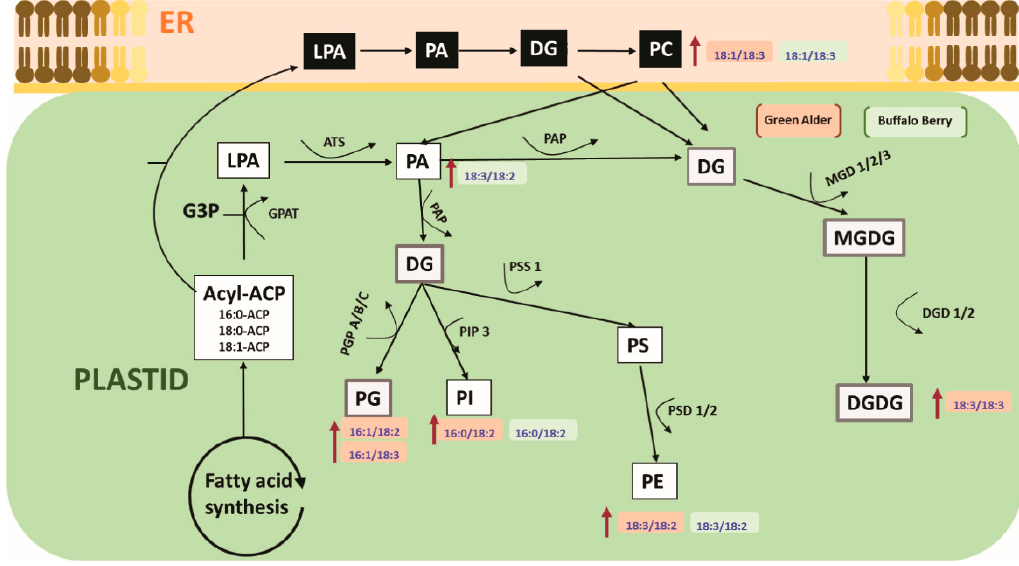
Figure 10. Proposed pathway showing the e ff ects of nanopriming with MWCNT–COOH on the membrane lipid metabolism of upland boreal forest species in response to resolving seed dormancy ER = endoplasmic reticulum, LPA = lysophosphatidic, PA = phosphatidic acid, DG = diacylglycerol, PC = phosphatidylcholine, PG = phosphatidyl glycerol, PI = phosphatidylinositol, PS = phosphatidylserine, PE = phosphatidylehanolamine, MGDG = monogalactosyldiacylglycerol, DGDG = digalactosyldiacylglycerol, PGP = glycerol-3-phosphate phosphatase, EPT = ethanolamine phosphotransferase, DGD = dialkylglycine decarboxylase, PAP = phosphatidic acid phosphatase, MGDG = monoalkylglycine decarboxylase, PSD = phosphatidylserine decarboxylase, PIP 3 = 1-phosphatidylinositol-4-phosphate 5-kinase, ATS = acetyl